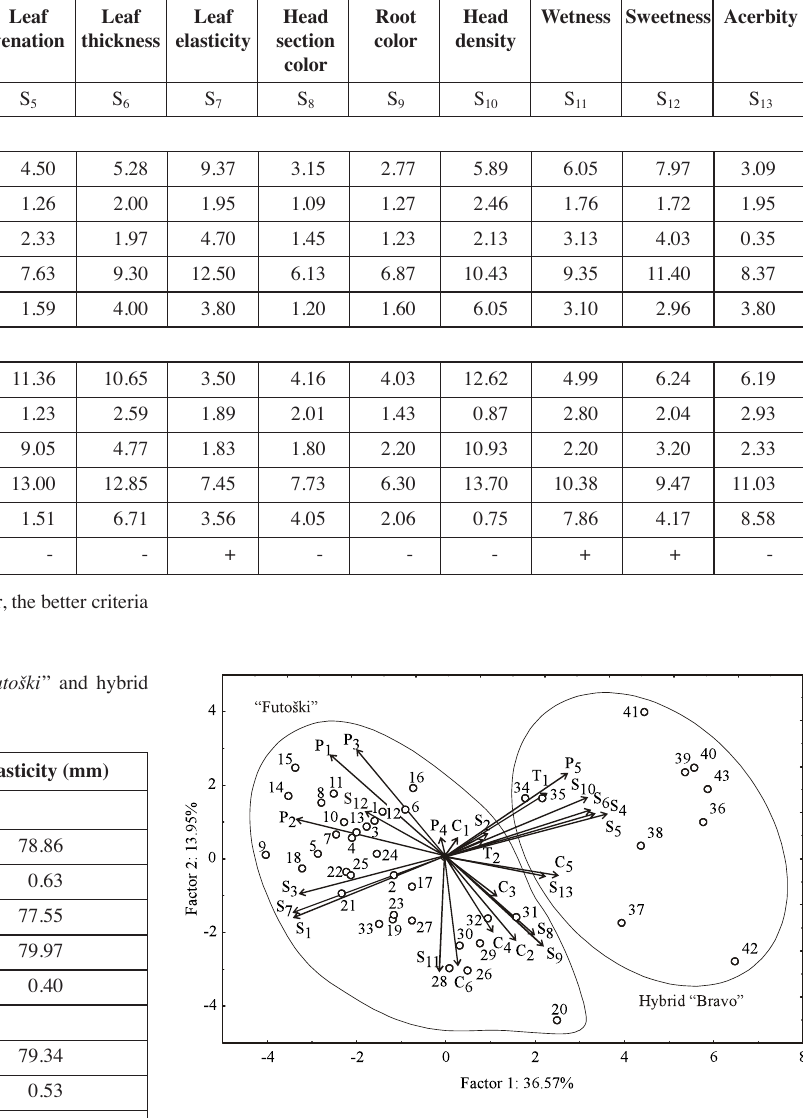
Fig. 1: Biplot for characteristics of cabbage